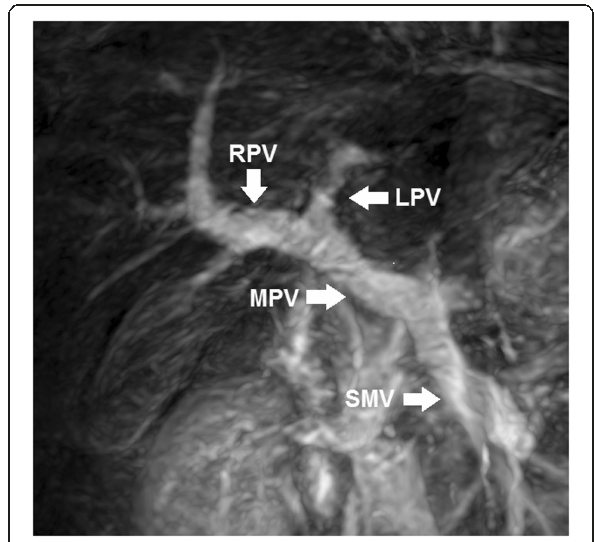
Fig. 2 Moderate quality scan. Coronal maximum intensity projection image from a non-contrast MR portography using T-SLIP technique showing respiratory motion artifacts due to patient ’ s irregular